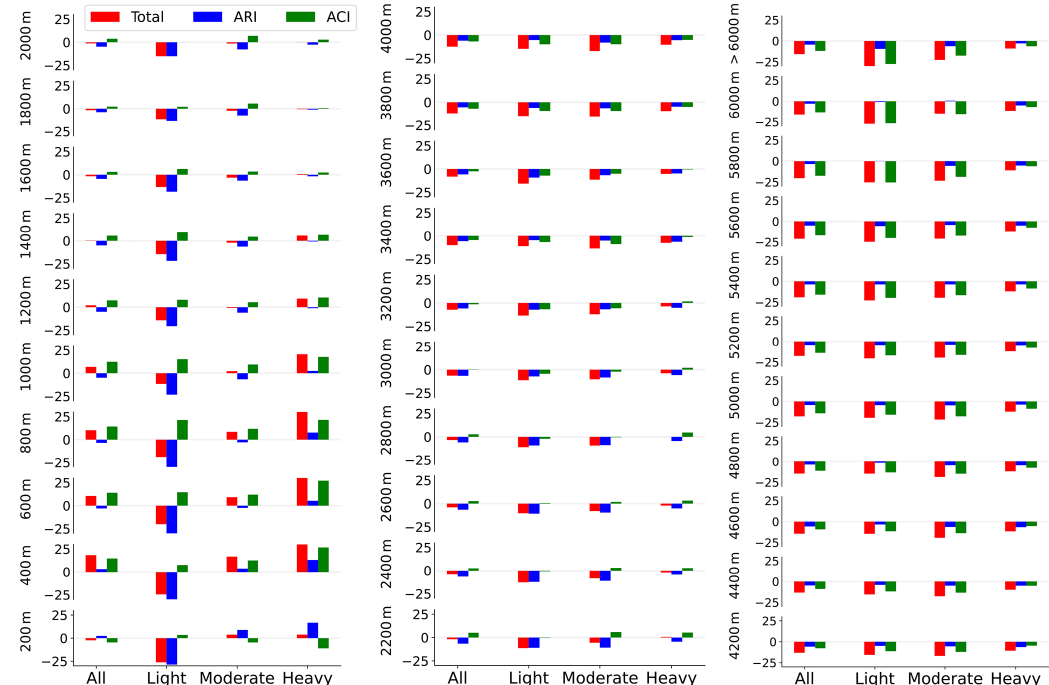
Figure 10. Relative change (%) in precipitation due to different effects of aerosols for all the elevational bins.